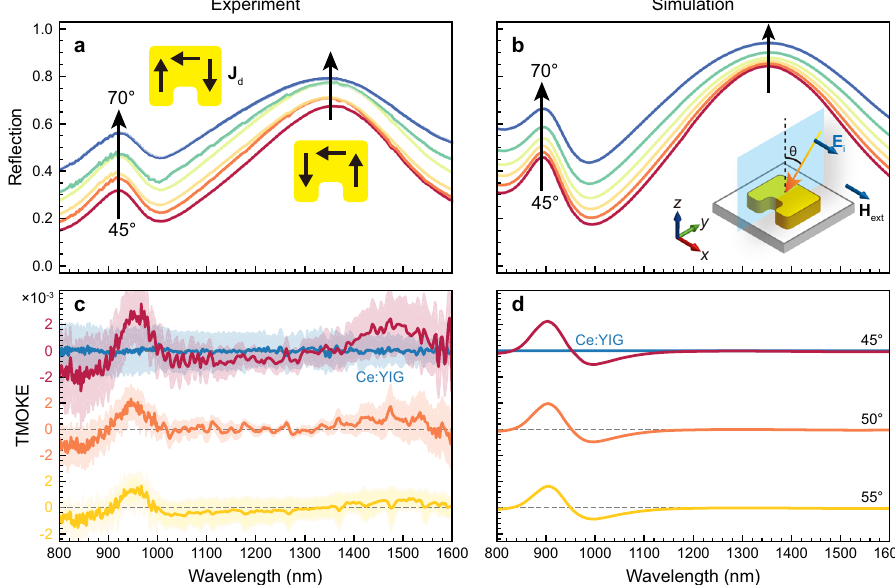
Fig. 3 Re fl ection and TMOKE spectra under s-polarized incidence. a Measured and b simulated re fl ection spectra of the MO-SRR metamaterial for incident angles ranging from 45° to 70° under s-polarized incidence. The inset of a shows the displacement current J d directions for the electric and magnetic resonances. The inset of b shows the schematic of the incident plane, polarization, and direction of applied magnetic fi eld H ext . c Measured and d simulated TMOKE spectra of the MO-SRR metamaterial and the Ce:YIG thin fi lm for different incident angles under s-polarized